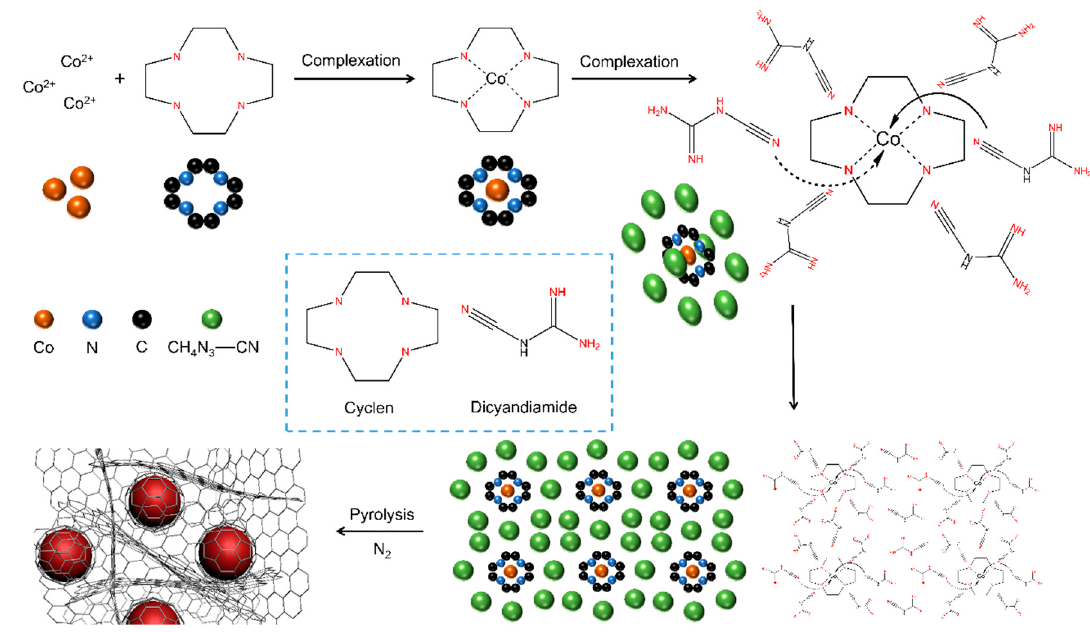
Scheme 1. Illustration of synthetic procedure and the formation mechanism for